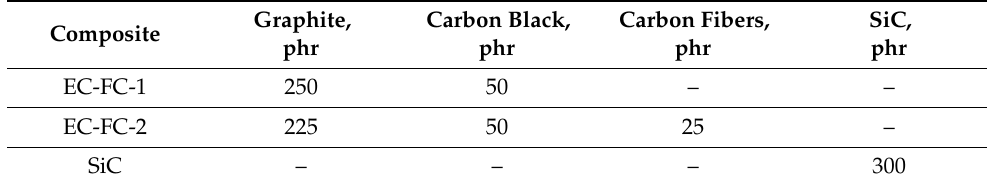
Table 2. Investigated compositions with